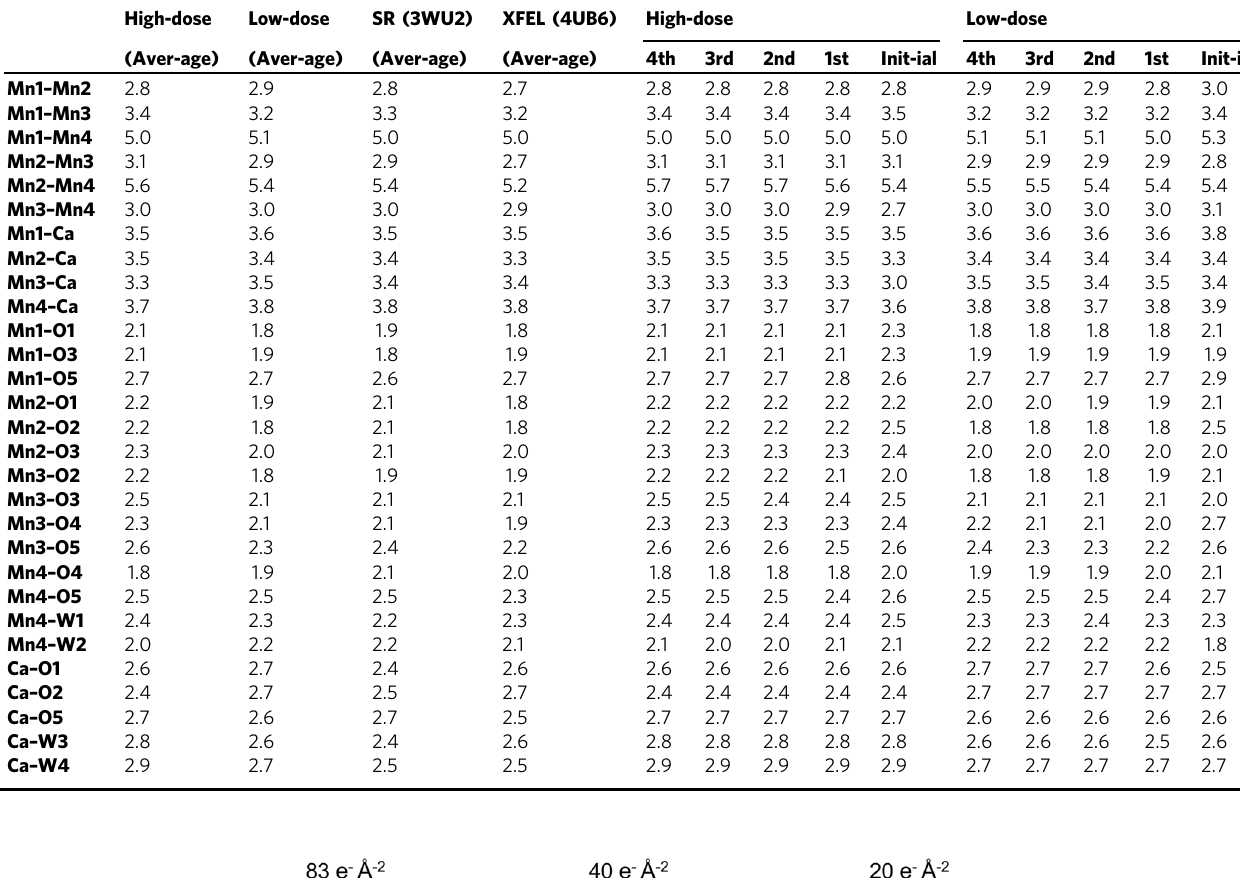
Table 3 Summarization of the distances of atoms of the Mn 4 CaO 5 cluster.